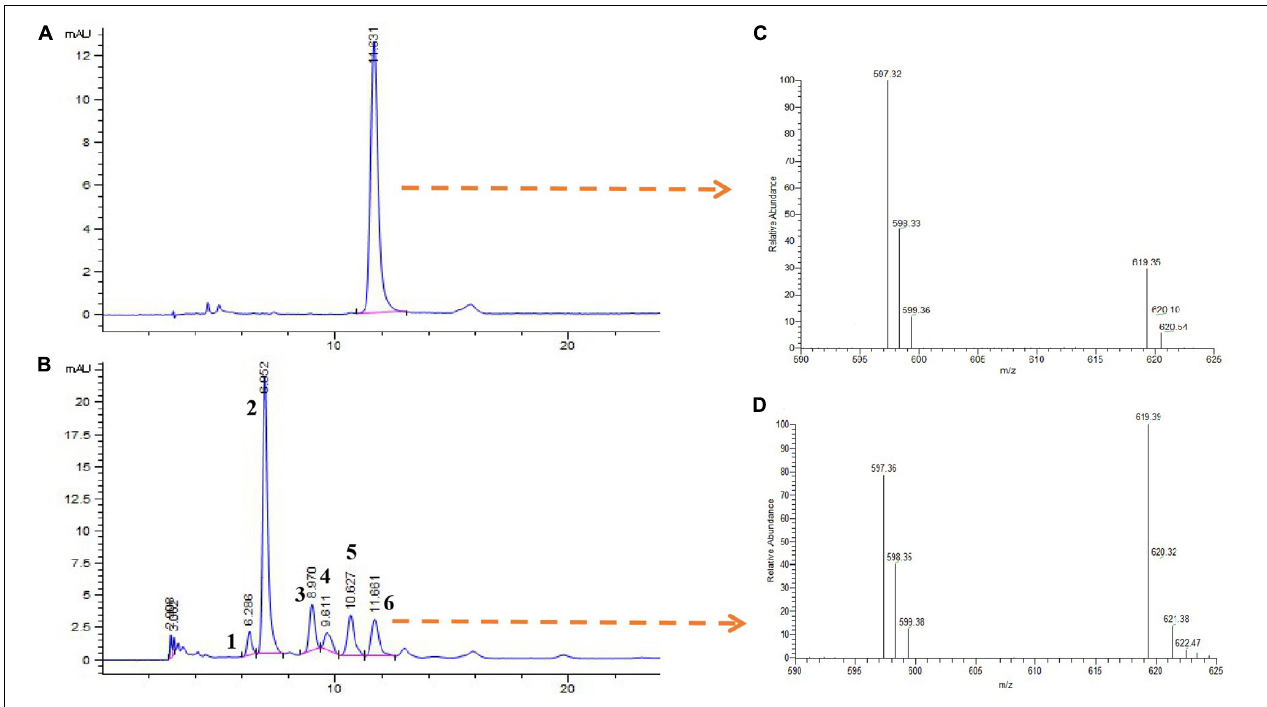
FIGURE 7 | High-performance liquid chromatography and mass spectra (HPLC-MS) analysis of carotenoid extract from the isolate Brevundimonas . HPLC elution profiles ( λ max 480 nm) of astaxanthin (A) and carotenoids produced by the isolate Brevundimonas (B) . Mass spectra of (C) astaxanthin standard and (D) astaxanthin produced by the isolate Brevundimonas (peak